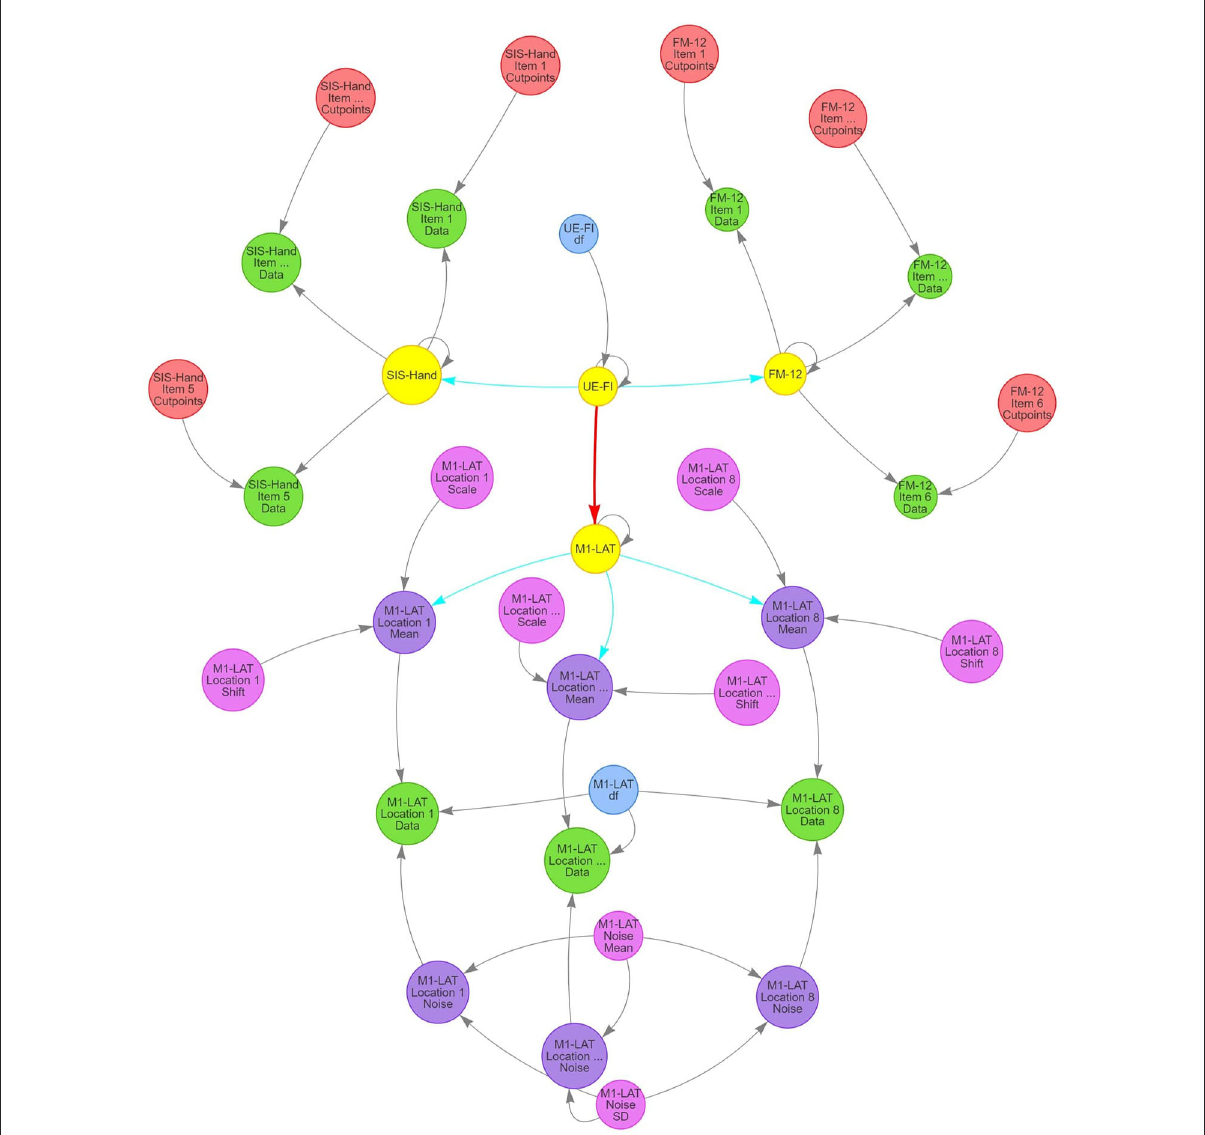
FIGURE4 Structure of SEM model used in present study to investigate the relationship between M1-LAT and post-stroke upper-extremity movement. Gray arrows signify deterministic links between constructs, blue arrows signify positively-constrained correlation parameters, and red arrows signify unconstrained correlation parameters. Critically, pink circles represent the main latent variables representing all functional assessments performed in the present study (i.e., FM-12 and SIS), as well as the latent UE-IF variable.